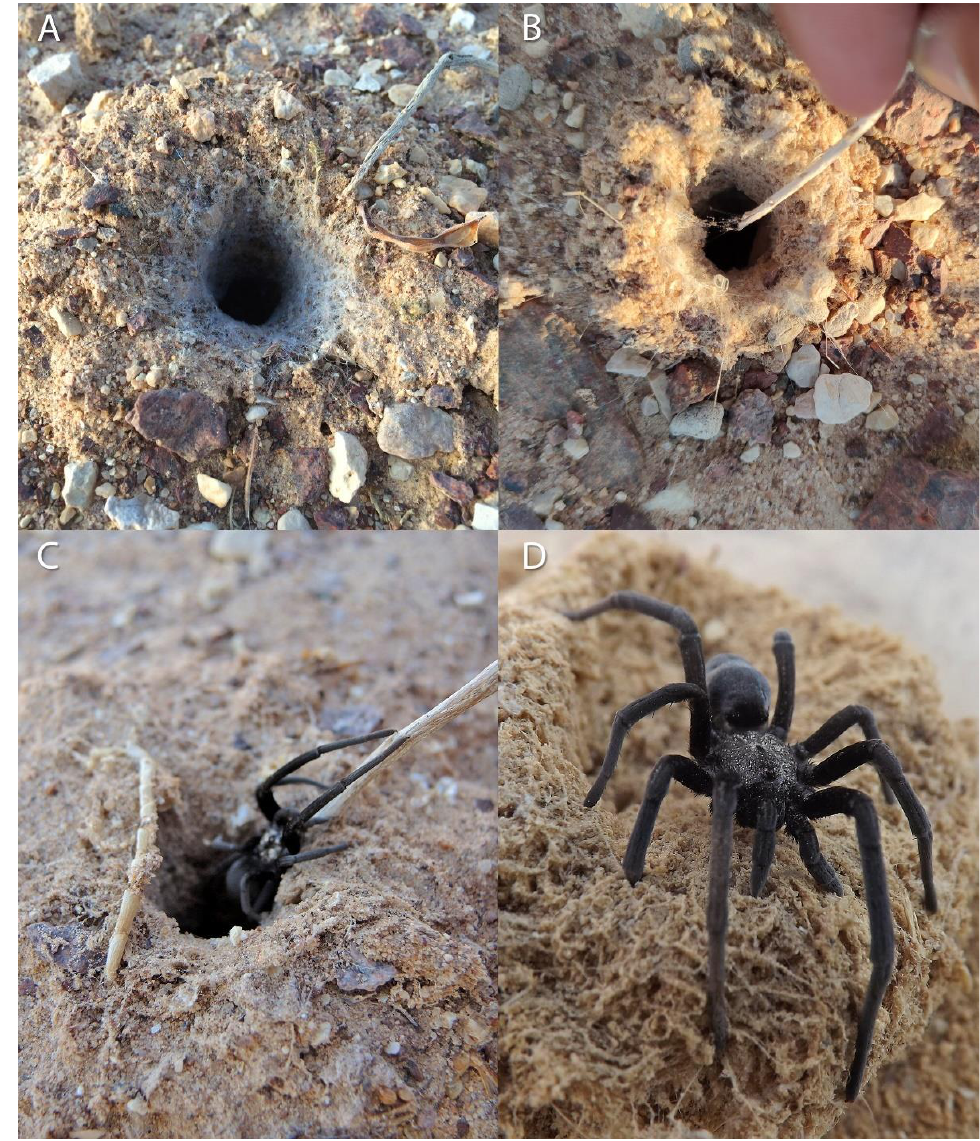
Figure 4. Presence of Sahastata spiders in burrows indicated by the spider response to stimulating the silk in the burrow entrance with a twig. Pictures: ( A ): Assaf Uzan, ( B ): Yoram Zvik, ( C , D ): Igor Armiach Steinpress.